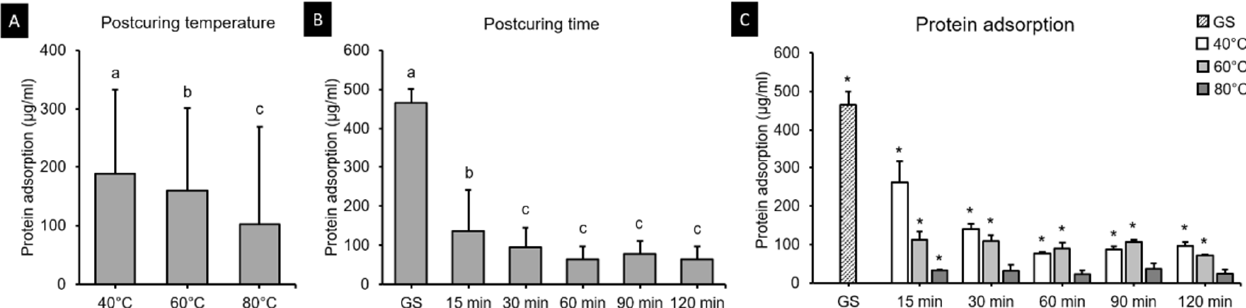
Figure 15. Results from protein adsorption assays. Mean and standard-deviation values are shown. ( A ) Two-way ANOVA showed that the protein adsorption decreased with postcuring temperature and ( B) did not differ significantly after 30 min of postcuring time. Different lowercase letters indicate a significant difference. ( C ) The protein adsorption for 40, 60 and 80 ◦ C groups. Asterisk indicates a significant difference from the PC in the t -tests.